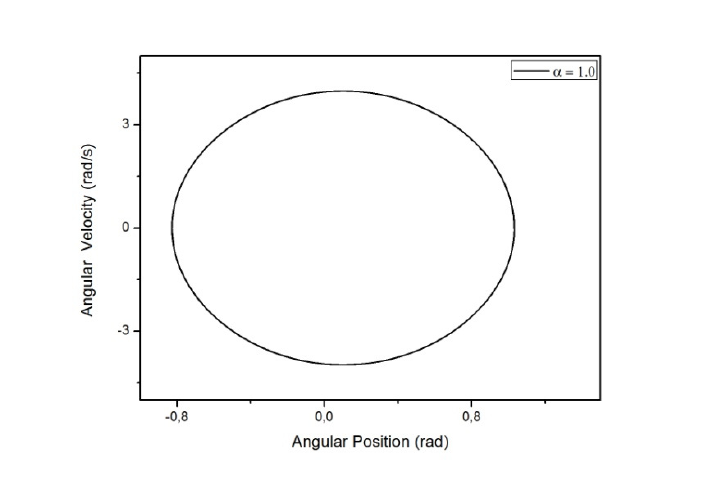
Figure 7. Pseudo-phase portrait (Case B for α = 0.9).